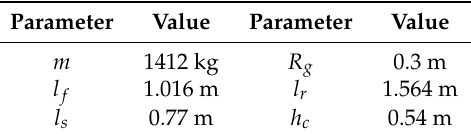
Table 1. Simulation parameters.